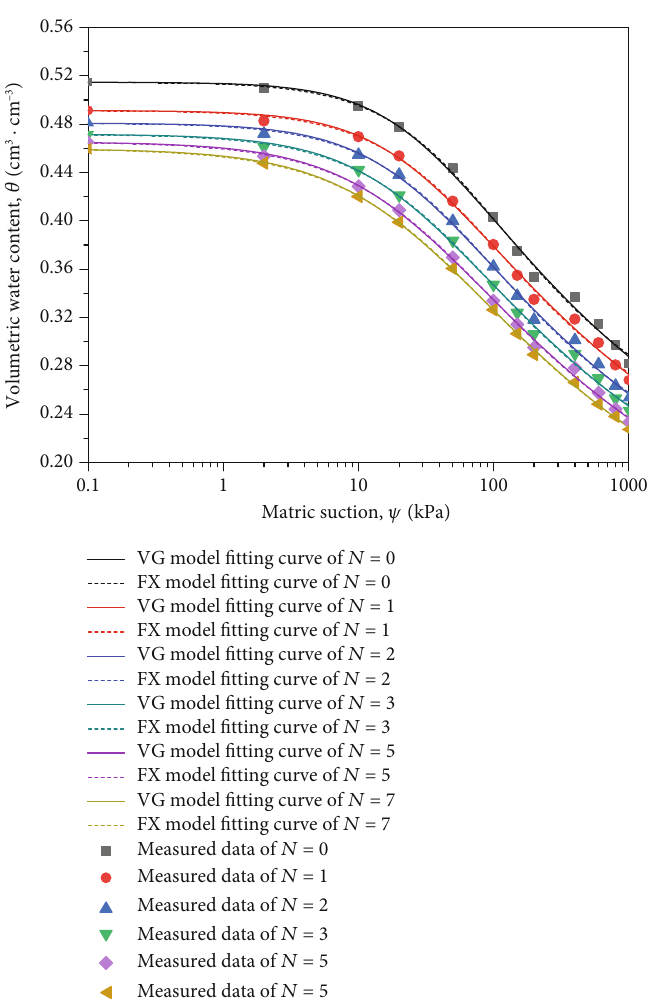
Figure 4: SWCC trend diagram of residual soil simulated by VG and FX model